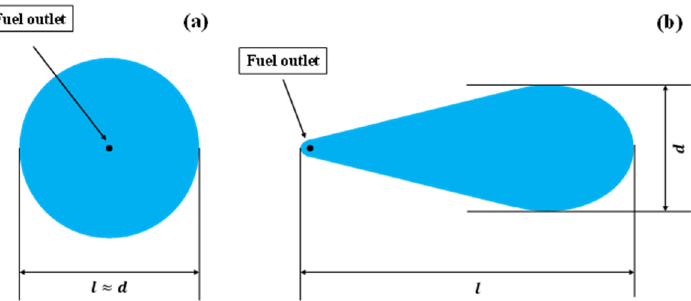
Figure 7. Approximate shape of spread area under ignited conditions. ( a ) On the flat surface; ( b ) On the inclined surface.